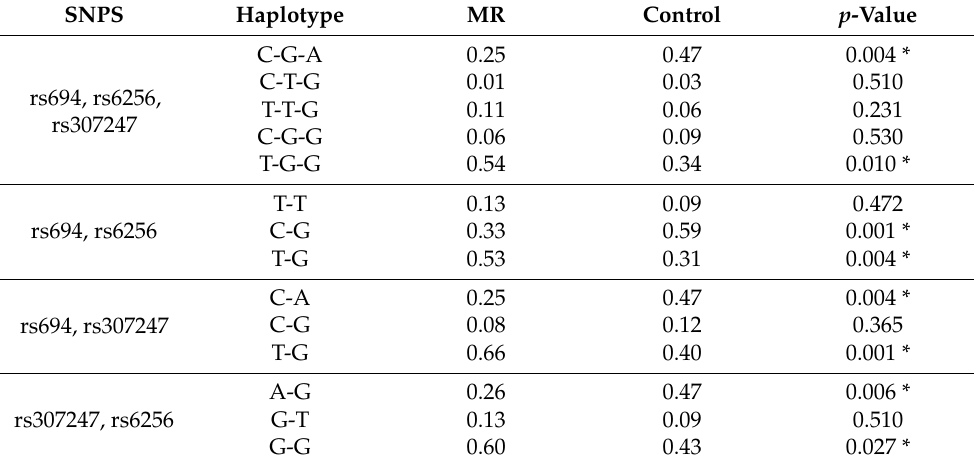
Table 5. Haplotype association analysis of SNPs in the PTH